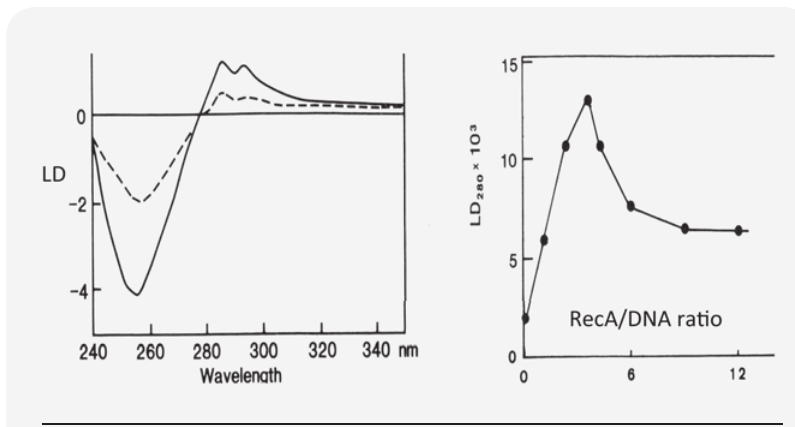
Figure 5. Linear dichroism (LD) of RecA-DNA under identical fl ow conditions as in Fig. 4. Titration of LD shows a stoichiometry of 3.6 base-pairs DNA per RecA protein unit. From the pitch of the RecA helix in Fig. 4, a DNA rise of 0.51 nm per DNA base is deduced, i.e. that the DNA is elongated by a factor × 1.5. From the amplitude of the negative LD peak at 255 nm and the S value deduced from Fig. 3, an angle θ = 70–90 ° is calculated from Eq. (1). Figure adapted from results in Refs. 20, 24.